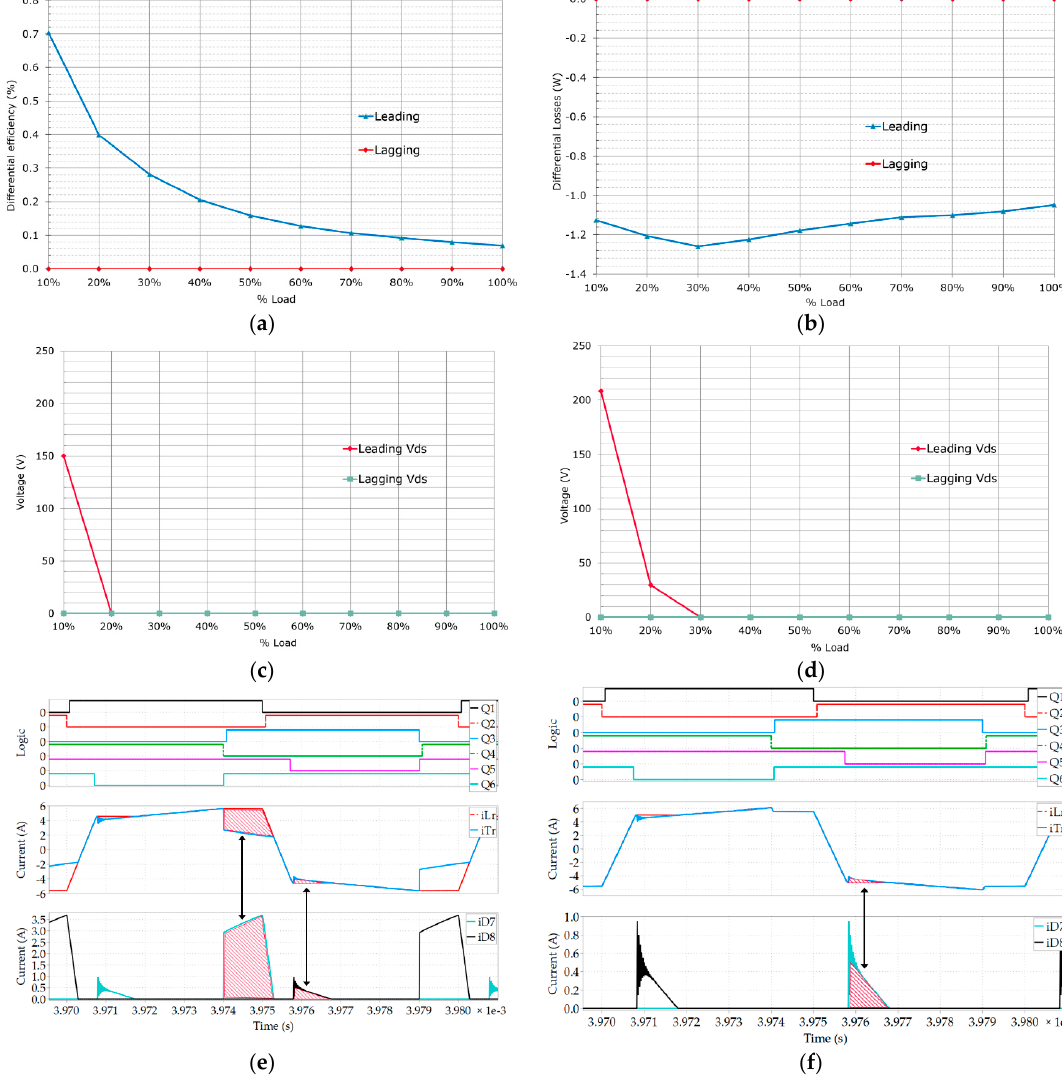
Figure 6. Efficiency for different clamping diodes’ configuration and the effect on switching voltage of the primary side HV MOSFETs and the primary side circulating currents: ( a ) differential efficiencies; ( b ) differential losses; ( c ) leading and lagging leg switching voltages with the clamping diodes on the lagging leg position; ( d ) leading and lagging leg switching voltages with the clamping diodes on the leading leg position; ( e ) primary side and clamping diodes current with clamping diodes in the lagging leg; ( f ) primary side and clamping diodes current with clamping diodes in the leading leg.